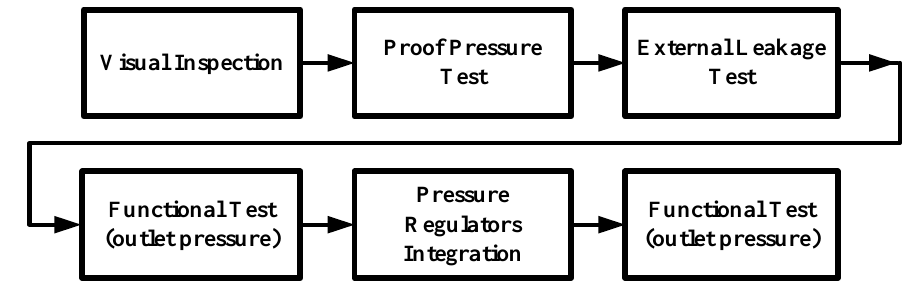
Figure 19. Flow chart showing the post-integration tests and checks for the Adelis-SAMSON nano- satellite propulsion system. nano-satellite propulsion